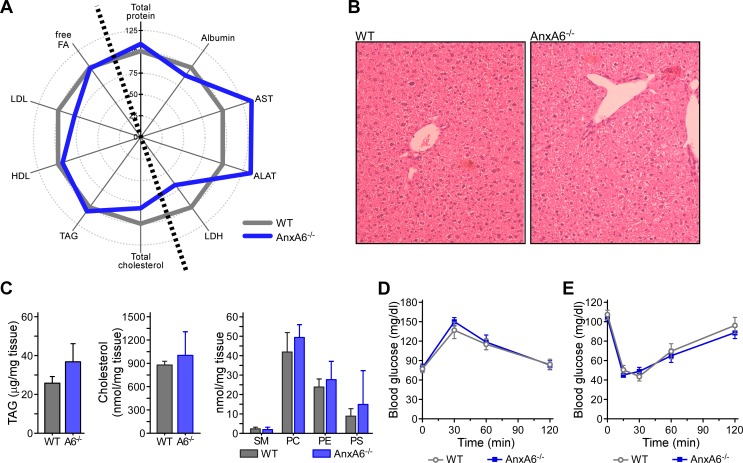
Liver function, lipid and insulin-regulated glucose metabolism are normal in chow-fed AnxA6-KO mice.(A) Spider diagram presentation of total protein, albumin, aspartate aminotransferase (AST), alanine aminotransferase (ALAT), lactate dehydrogenase (LDH), as well as total cholesterol, triglycerides (TAG), low density lipoprotein (LDL), high density lipoprotein (HDL), and free fatty acids (free FA) in the plasma of 8–12 weeks old wildtype (WT) and AnxA6-KO animals (AnxA6-/-) on a chow diet (n = 4). The data are presented relative to WT (100%). For absolute values, see text and [28] for further details. (B) H&E staining of liver sections from WT and AnxA6-KO mice on a chow diet. (C) Liver homogenates from 8–12 weeks old WT and AnxA6-KO mice were analyzed for triglyceride, cholesterol and phospholipid content as described in Material and Methods (mean ± SEM, n = 8). SM, sphingomyelin; PC, phosphatidylcholine; PE, phosphatidylethanolamine; PS, phosphatidylserine. (D) WT and AnxA6-KO mice on a chow diet were starved for 4 h prior to receive glucose via oral gavage (1 g/kg body weight). Blood glucose levels were determined 0–120 min after glucose administration (mean ± SEM, n = 6). (E) WT and AnxA6-KO mice received insulin (1.5 U/kg bodyweight) or saline via intraperitoneal injection. Blood glucose was measured at t = 0–120 min post-injection (mean ± SEM, n = 6). (D-E) Data points for t = 0 and 30 min have been described previously [28].